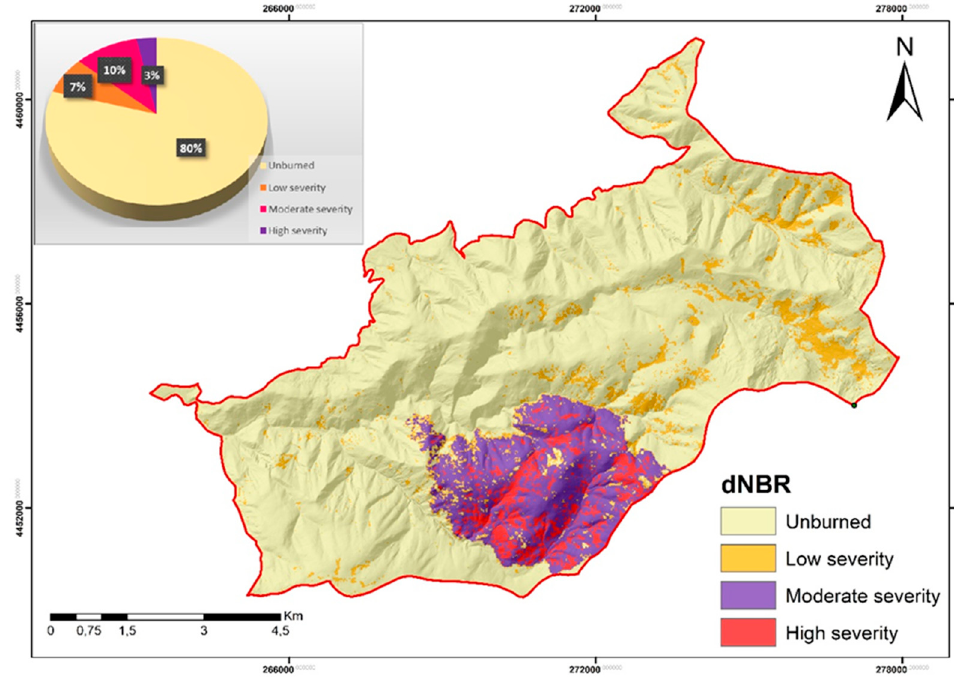
Figure 3. Map of areas of forest fires severity by the NBR and occupancy graph by severity. Table 3. Table of the output of the SPSS with the results of the Pearson correlation between the factors that cause erosion and soil loss. Factor C NDVI Factor R RUSLE Correlation of Pearson − 0.291 ** − 0.291 ** 0.226 ** 1 Sig. (Bilateral) 0.000 0.000 0.001 RUSLE N 200 200 200